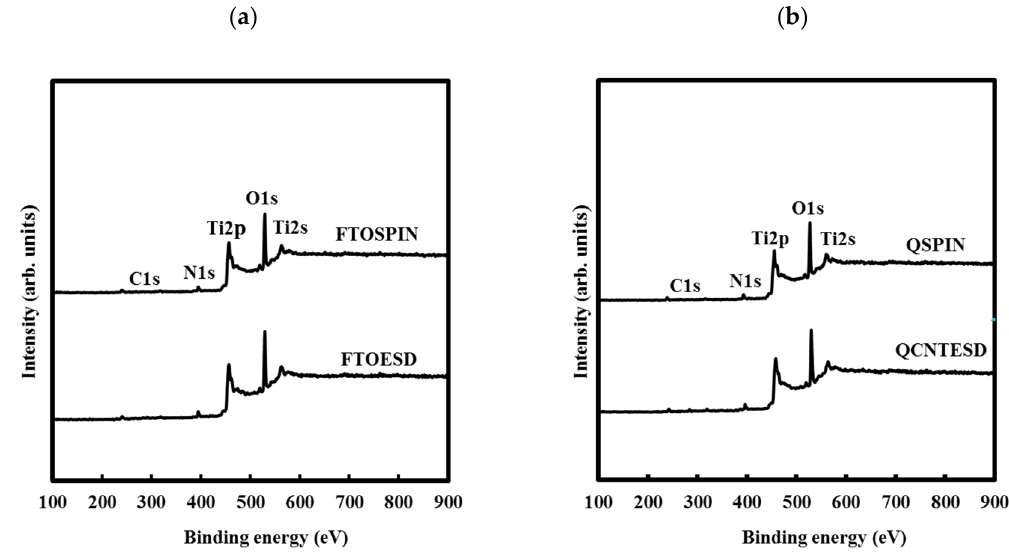
Figure 4. Wide-range XPS profiles of the titania thin films: ( a ) FTOESD and FTOSPIN; ( b ) QCNTESD and QSPIN.